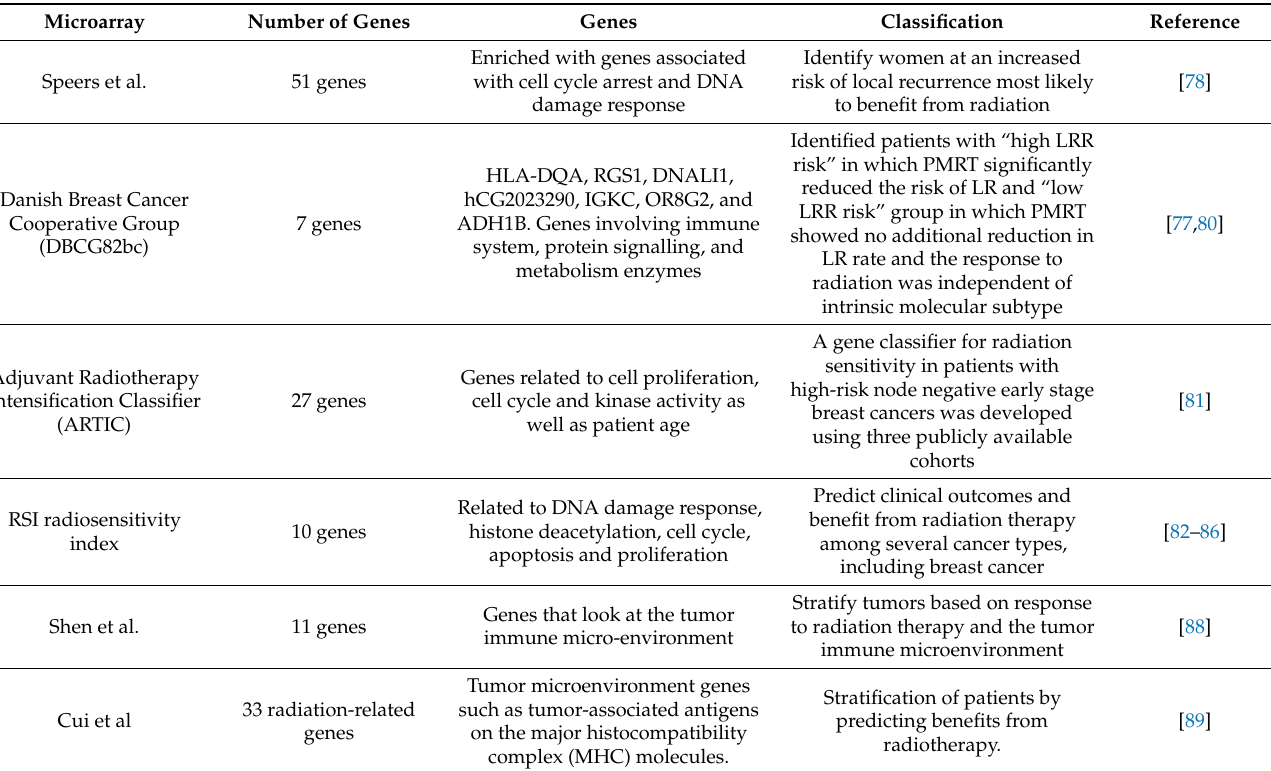
Table 3. Summary of gene expression profiles found to be associated with radiation resistance in breast